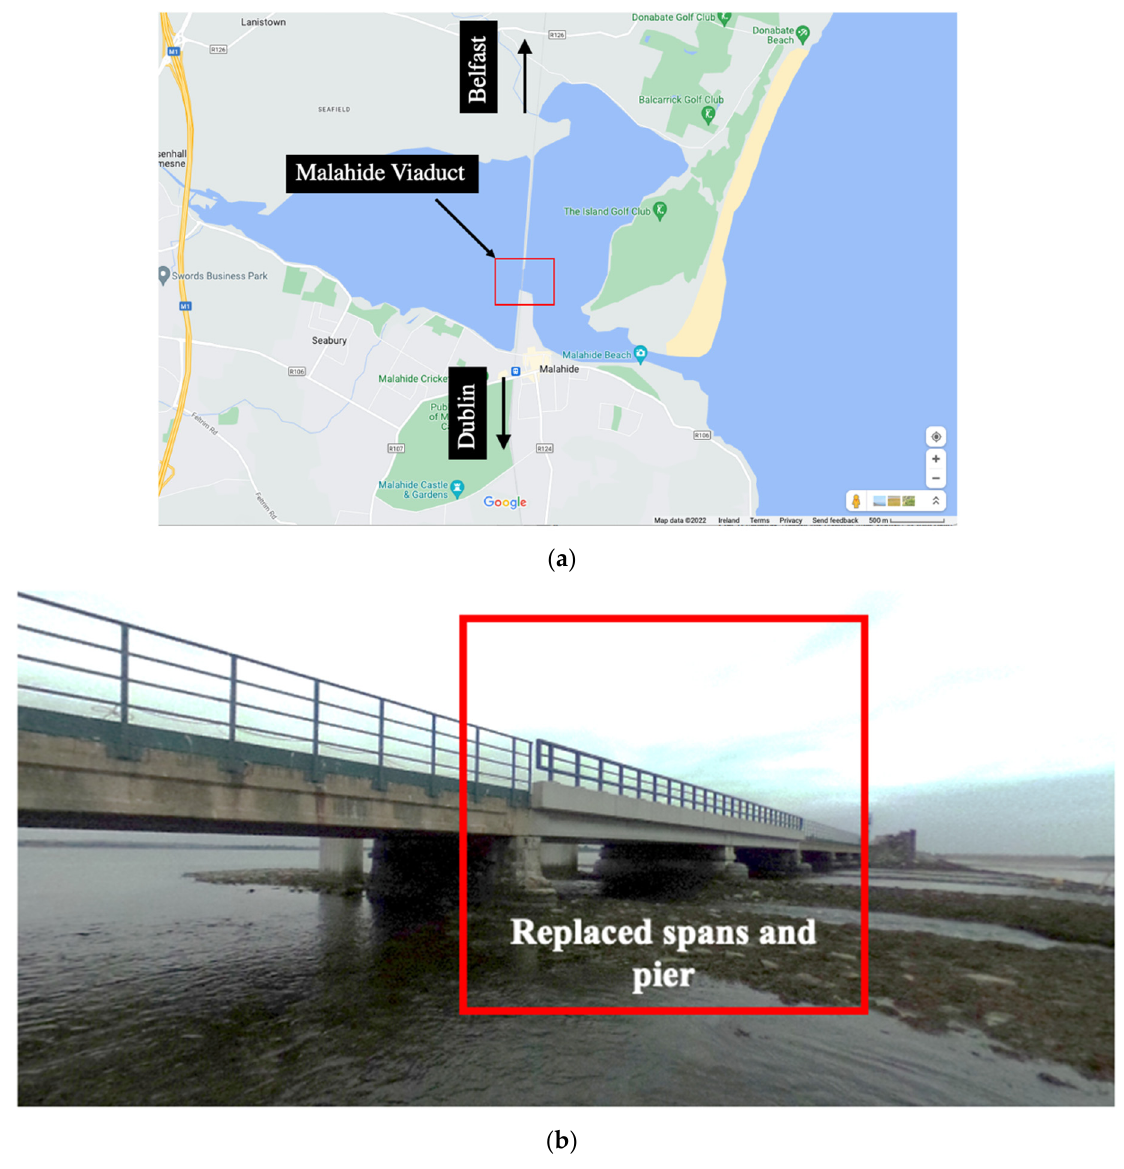
Figure 1. ( a ) Location of the Malahide Viaduct (12-span bridge) (taken from Google Maps), and ( b ) photograph of the viaduct with box showing the location of the replaced spans, Span 4 and Span 5, and the pier) (courtesy of Irish Rai).